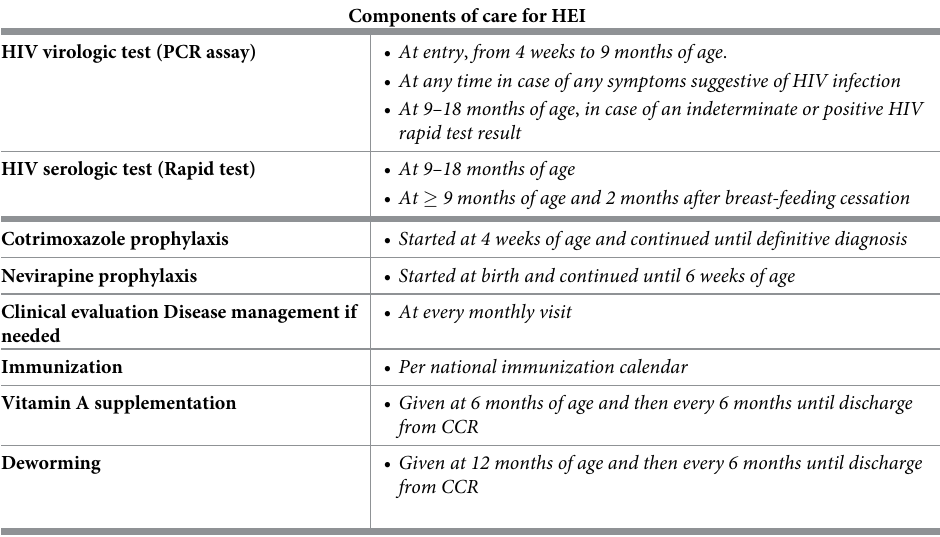
Table 1. The Ministry of Health package of care offered to